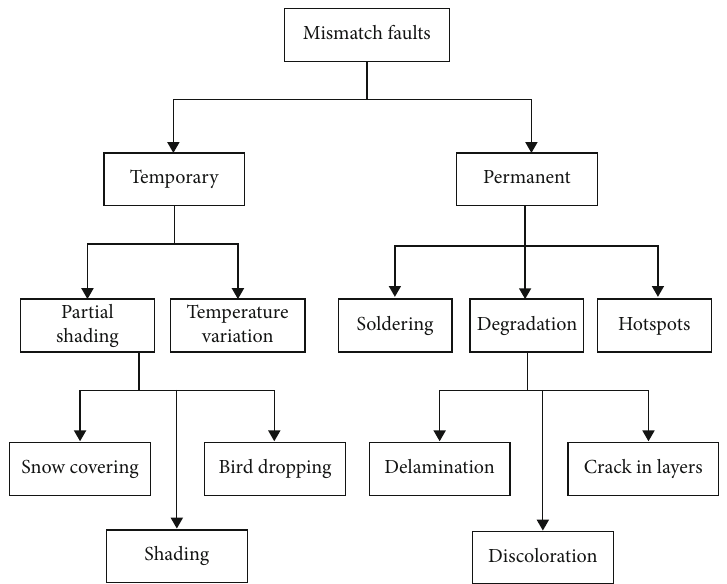
Figure 5: Classi fi cation of mismatch losses in solar photovoltaic module [171].